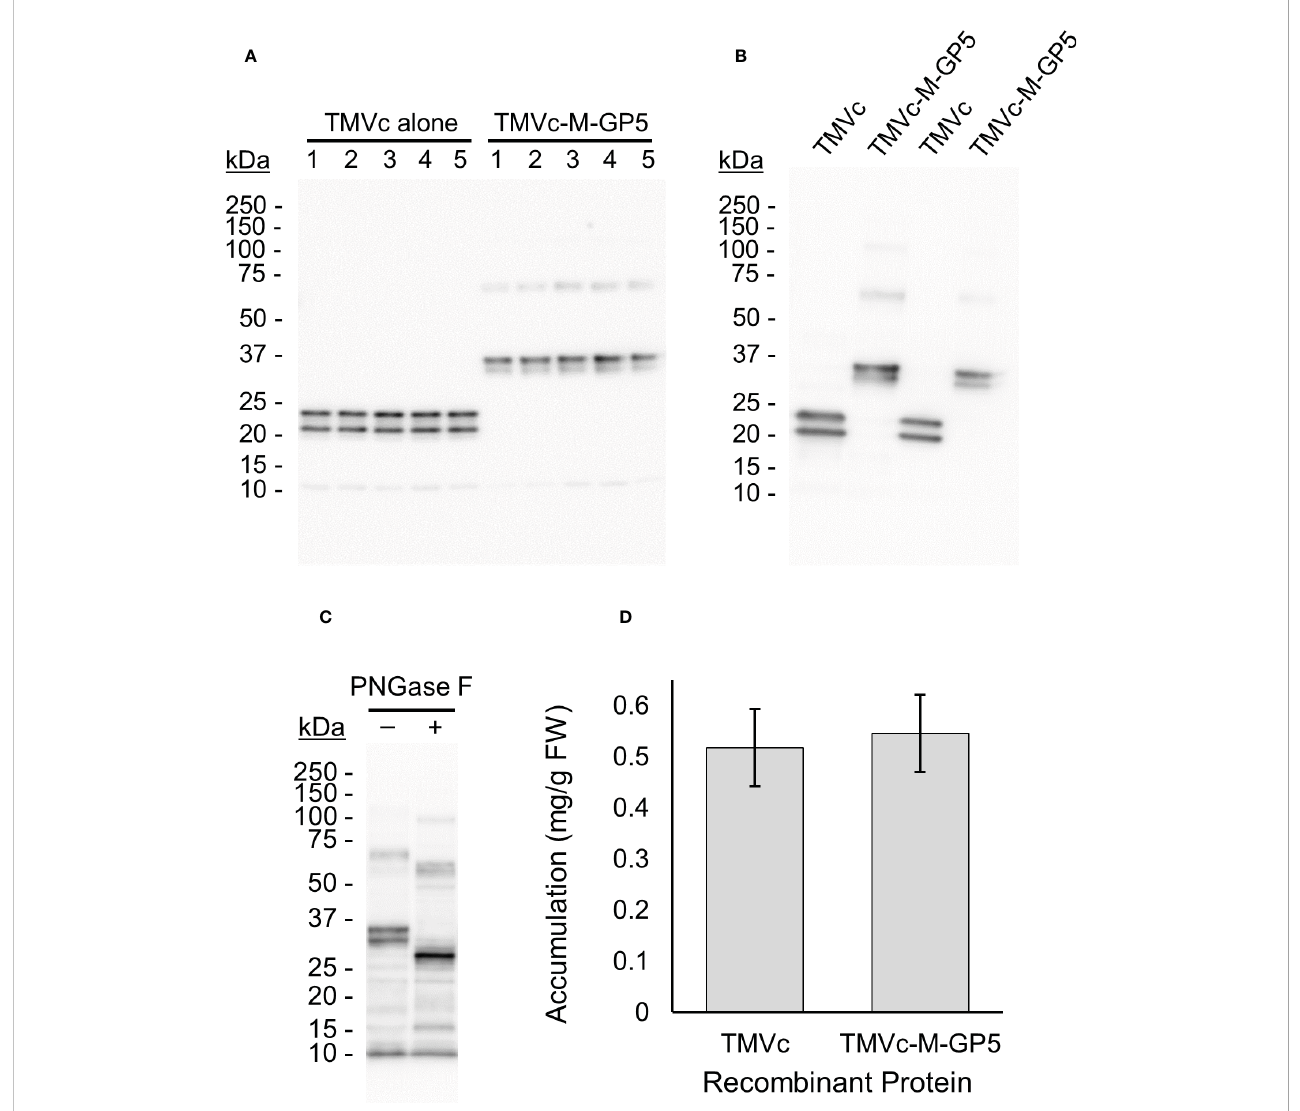
FIGURE 4 TMVc-M-GP5 accumulates well in plants and is ef fi ciently glycosylated. All proteins were targeted to the apoplast and sampled on 7 dpi. (A) The numbers across the top (1-5) identify different plants considered biological replicates. The expected size of the fully glycosylated TMVc and TMVc-M-GP5 monomers are 24.3 kDa and 32.5 kDa, respectively. The 70 kDa band observed for TMVc-M-GP5 may be due to dimerization. A standard curve was generated with known amounts of a protein standard and used for quanti fi cation. In each lane 5 µl of total soluble plant proteins were loaded corresponding to approximately 0.5 mg of plant tissue fresh weight. Exact tissue weights were recorded and considered for accumulation values. This blot was probed with an anti-HA primary antibody, and is representative of three transient expression experiments. (B) TMVc and TMVc-M-GP5 immunoblot probed with an anti-c-Myc primary antibody. Two replicates are shown for each protein. The same double banding pattern as probing with an anti-HA primary antibody is observed. (C) Deglycosylation of TMVc-M-GP5 with PNGase F (+) shows a single band at the expected molecular weight of the unglycosylated protein, compared to the double banding observed for the untreated protein ( – ). This blot was probed with an anti-HA primary antibody. (D) The mean recombinant protein accumulation levels of 15 biological replicates over three independent experiments (5 biological replicates per experiment) are shown in milligrams of recombinant protein per gram of plant fresh weight (FW), with the bars above and below representing 95% con fi dence intervals. No signi fi cant difference in recombinant protein accumulation was observed, as assessed by